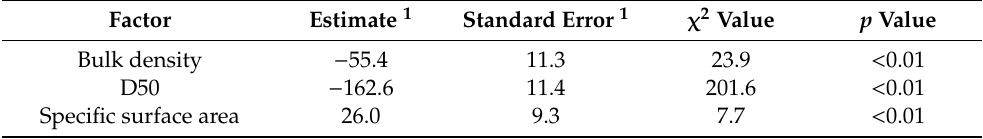
Table 2. Crucial powder properties a ff ecting % retention of TS estimated using the ENET technique. Factor